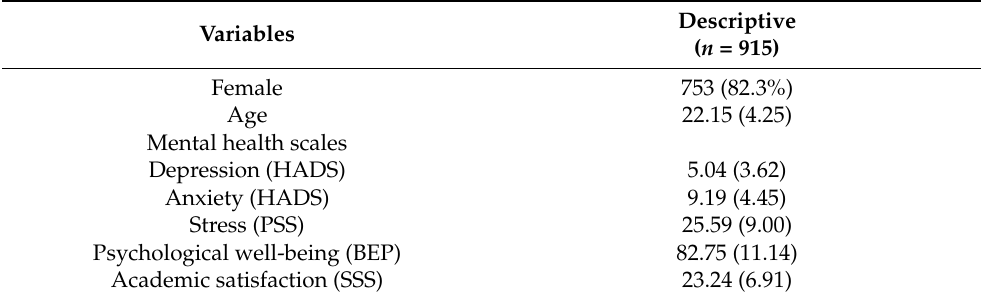
Table 1. Gender, age, health disciplines, and questionnaires scores (means